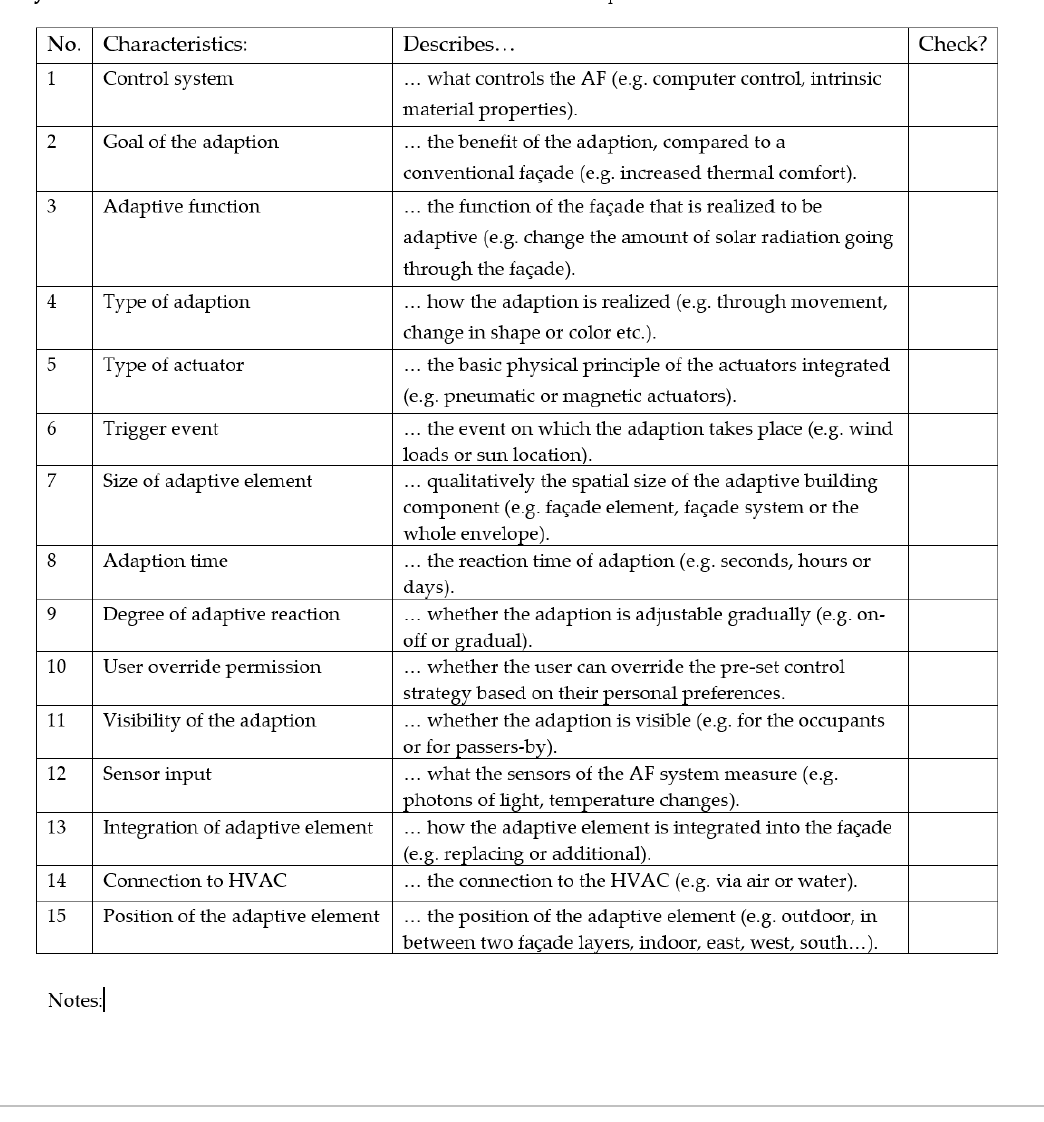
Figure 11. Developed checklist for the early-stage discussion of suitable design goals.